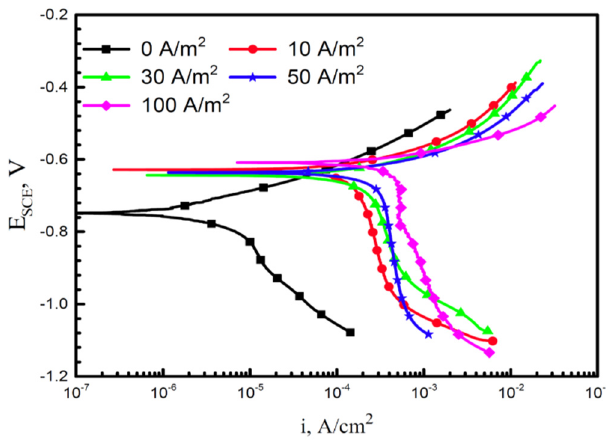
Figure 14. Polarization curves on X70 steel tested at various AC densities in simulated seawater [49].